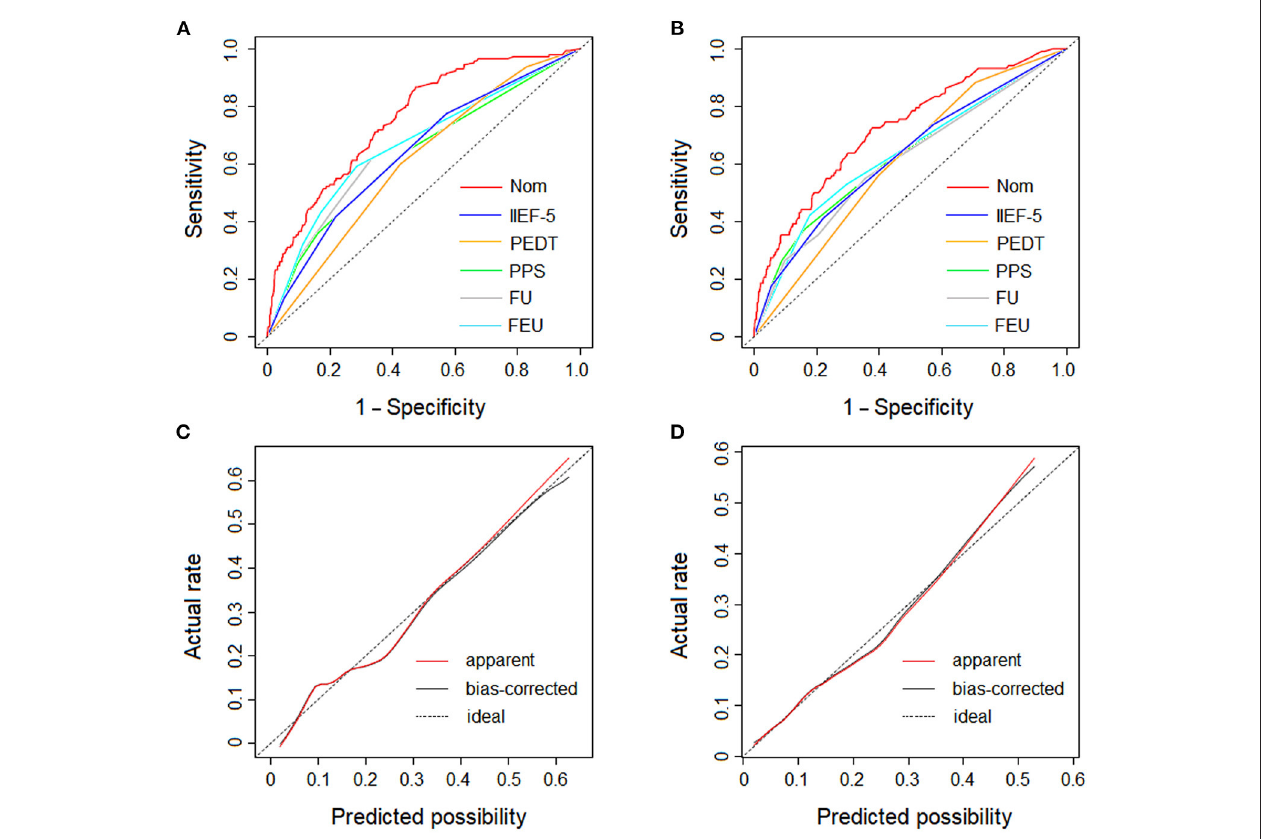
FIGURE 4 | The ROC curves and the dotted line represents of the derivation cohort and validation cohort. (A) The ROC curves of the nomogram, IIEF-5 score, PEDT score, physical pain score, frequent urination and feeling of endless urination in derivation cohort. (B) The ROC curves of the nomogram, IIEF-5 score, PEDT score, physical pain score, frequent urination and feeling of endless urination in validation cohort. (C) The calibration plot of the nomogram in derivation cohort. (D) The calibration plot of the nomogram in validation cohort. The dotted line represents the calibration of an ideal nomogram (the predicted risk perfectly corresponds to the actual rate). The red solid line represents the apparent accuracy of the nomogram without correction for overfitting, while the black solid line represents the bootstrap-corrected nomogram. (Nom, nomogram; IIEF-5, 5-item International Index Erectile Function; PEDT, premature ejaculation diagnostic tool; PPS, physical pain score; FU, frequent urination; FEU, feeling of endless